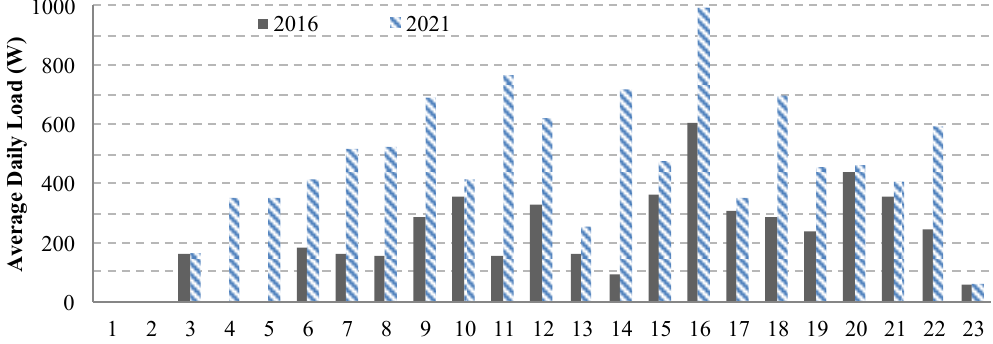
Fig 5. Load curve in 2016 and projected